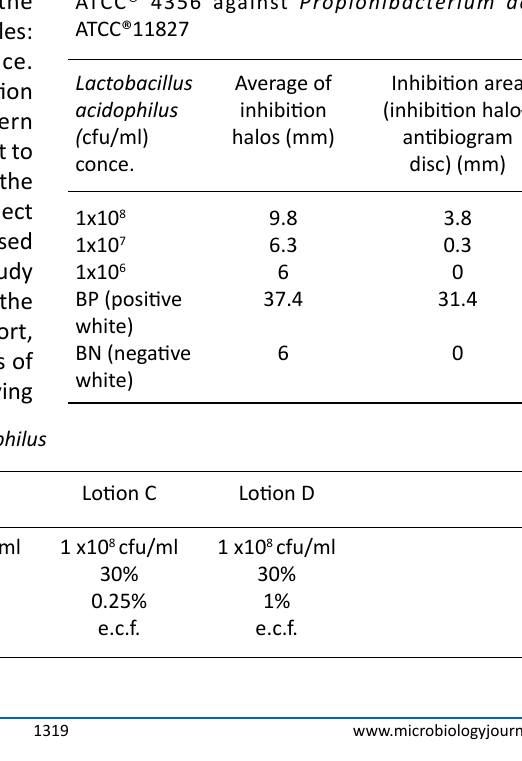
Table 2. Inhibition halos of Lactobacillus acidophilus